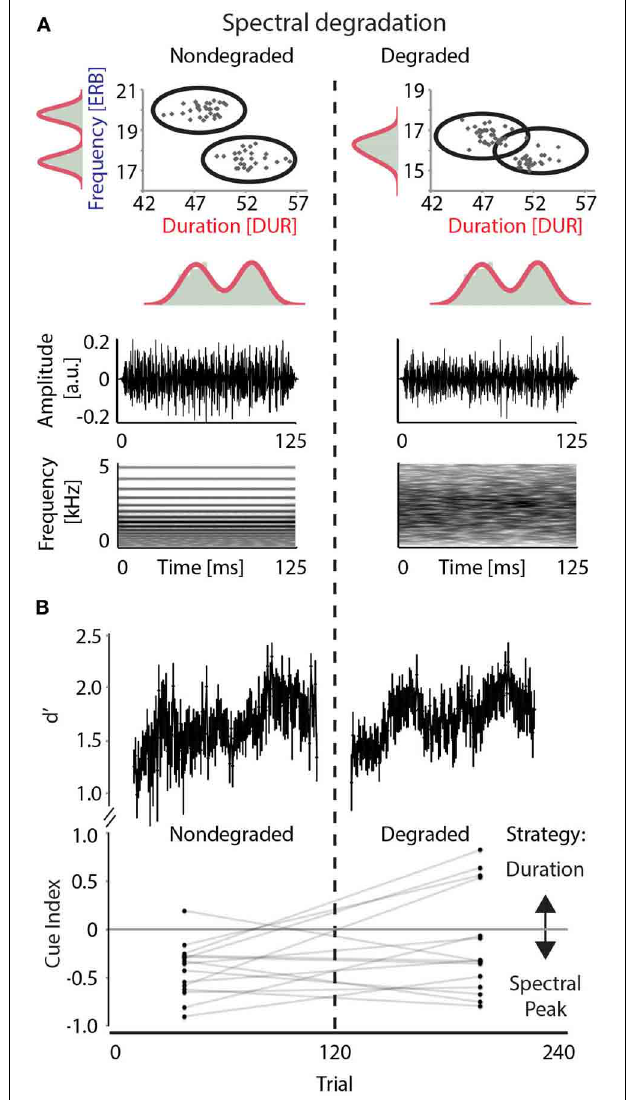
FIGURE 1 | Stimulus characteristics and behavioral results. (A) Top : Complex sounds differing in spectral peak (expressed in ERB; y-axis) and duration (expressed in DUR; x-axis). Distributions are indicated by ellipses, with black dots illustrating distributions for a representative participant. Bottom : Stimulus wave form and spectrogram illustrate the complex structure of sounds in the nondegraded condition (left) and the spectral smearing as a result of vocoding in the degraded condition (right). Duration and amplitude envelope were unaffected by degradation. (B) Results of behavioral discrimination. Top : Perceptual sensitivity (d (cid:3) ) over time, obtained from sliding windows over nondegraded and degraded trials per participant (window size = 20 trials, step size = 1 trial). Bottom : Comparison between by-subject cue indices in the nondegraded and degraded conditions. Mean cue index values for the nondegraded and the degraded conditions are connected for each